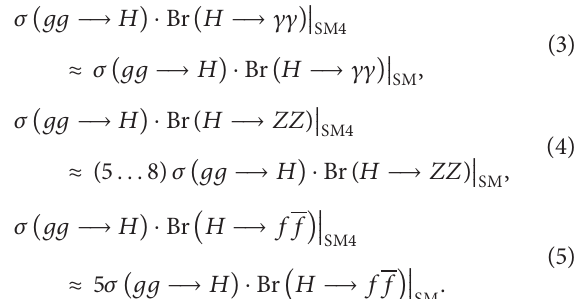
Figure 2: Allowed mass splitting of fourth generation fermions accordingtotheconstraintsfromelectroweakprecisionobservables. One clearly sees that mass degenerate quarks of the fourth family are not ruled out. Note, that for this result CKM mixing was neglected. Figure from